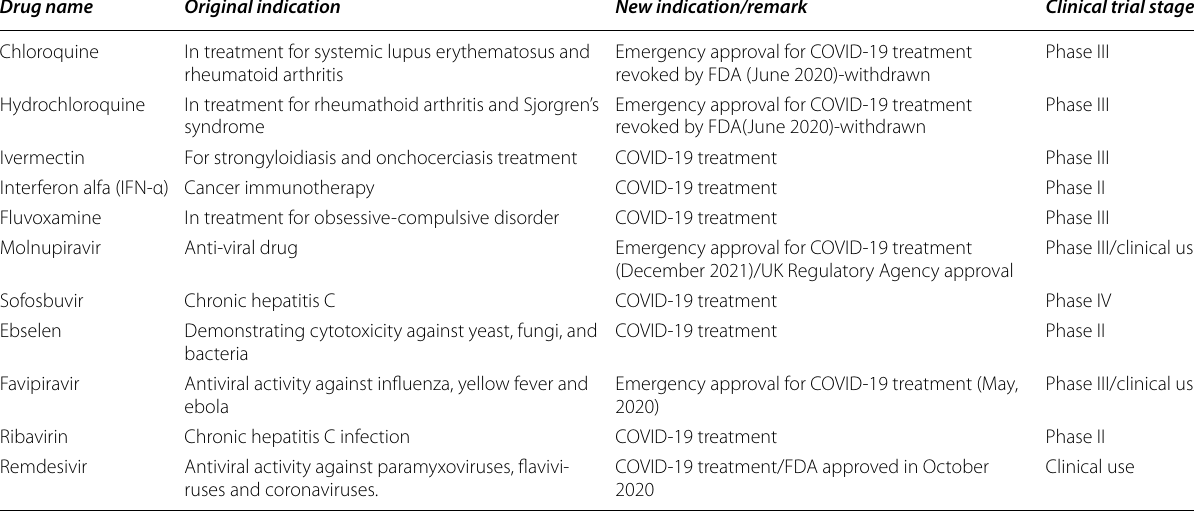
Drug clinical stage information available at: www. clini caltr ial.